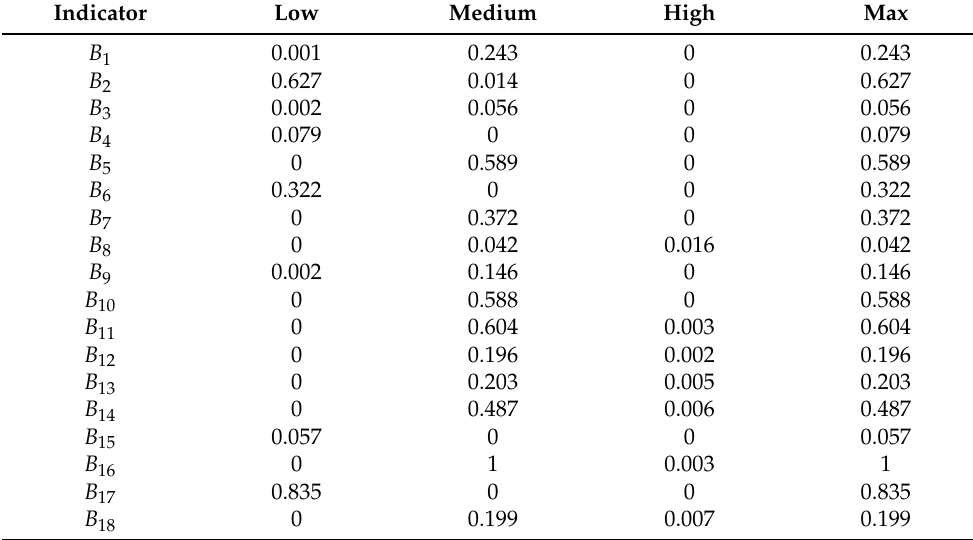
Table 12. Comprehensive